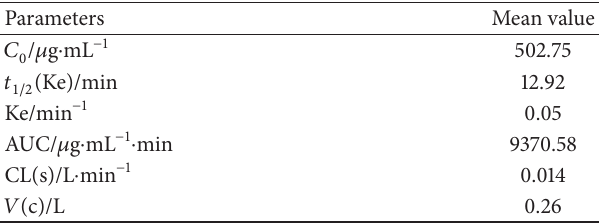
Table 2: Pharmacokinetics mean parameters of 4 components and potential metabolites in rat after Yangxue injection